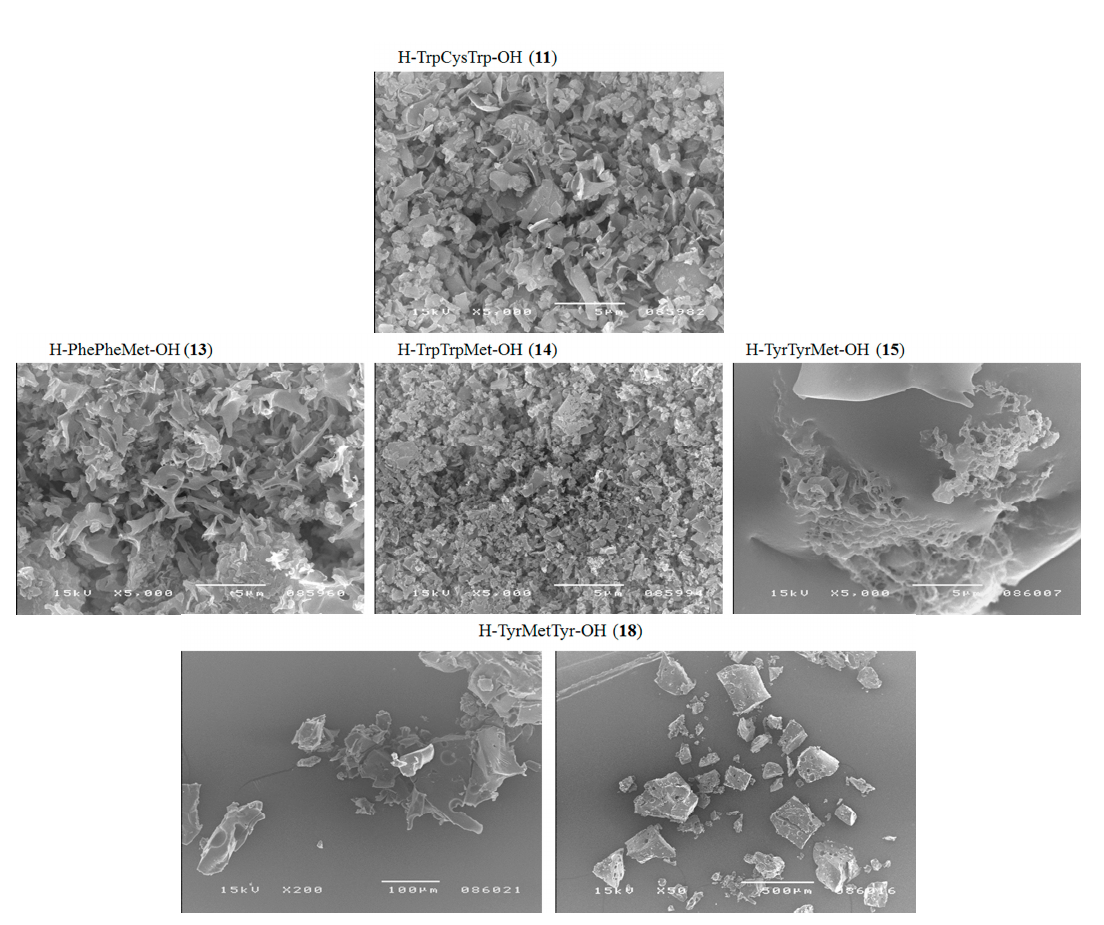
Figure 7. 3D structures of selected peptides, scanning electron microscopy images.